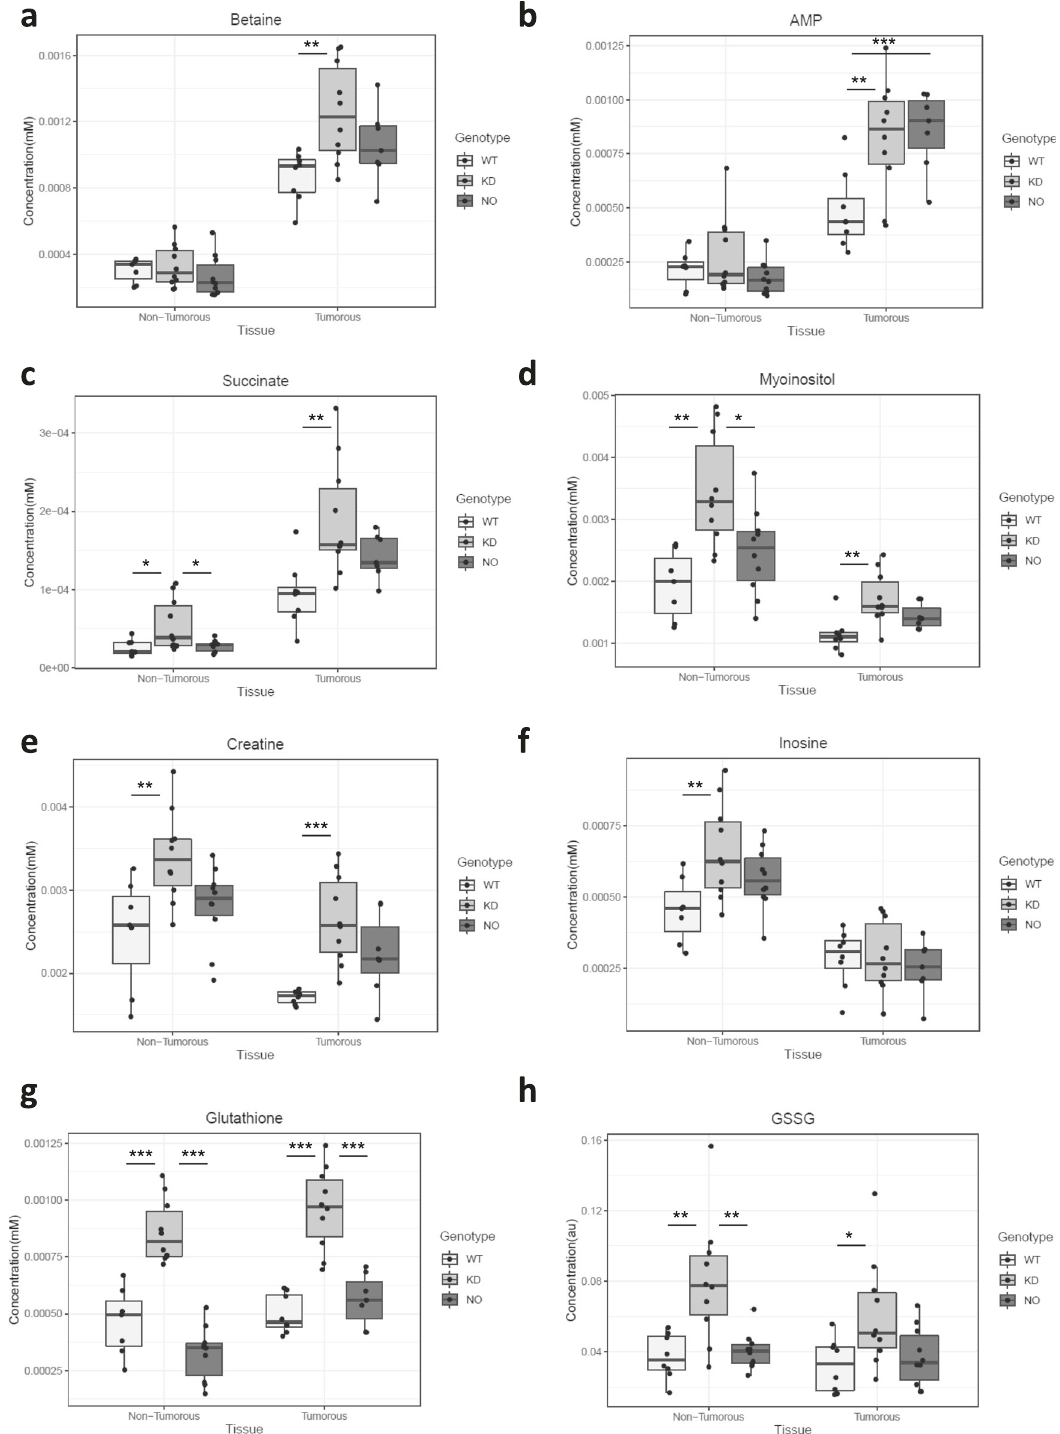
Fig. 6 Colorectal adenomas have altered metabolite levels in comparison with matched peri-tumorous tissue. a – f Concentration of selected metabolites in peri-tumorous and tumorous tissues of wild-type (white bars), Keap1-KD (gray bars) and Nrf2-KO (black bars) mice as measured by NMR. ( a ) betaine, ( b ) AMP, ( c ) succinate, ( d ) myo-inositol, ( e ) creatine, ( f ) inosine. g , h Concentration of glutathione (GSH) ( g ) and GSSG ( h ) in peri-tumorous and tumorous tissues of wild-type (white bars), Keap1-KD (black bars) and Nrf2-KO (gray bars) as measured by NMR. *0.05 > p > 0.01, ** 0.01> p > 0.001, *** p < 0.001, using ANOVA followed by Tukey post-hoc test for statistical signi fi